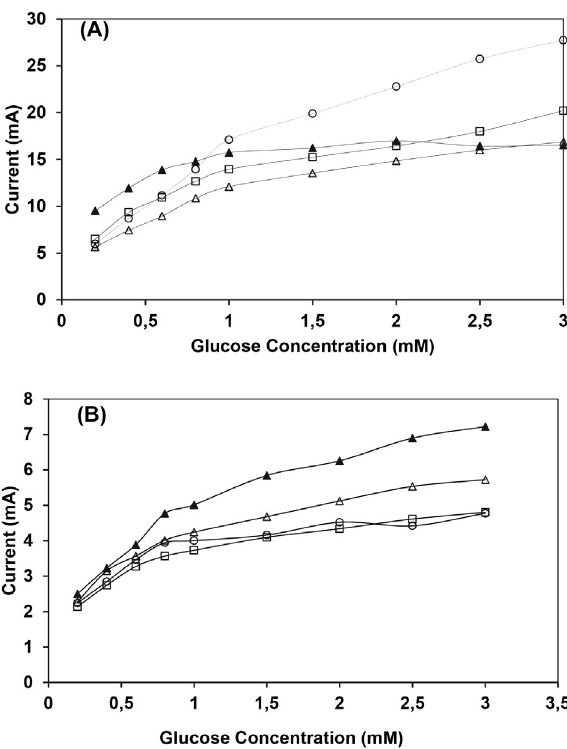
Figure 6. Current response of PPy (A) and POA (B) based biosen- sors modified with ZnONP.  :ZnONP-free;  :0.1;  :0.5 and  : 2 mg ZnONP/ml Chi.